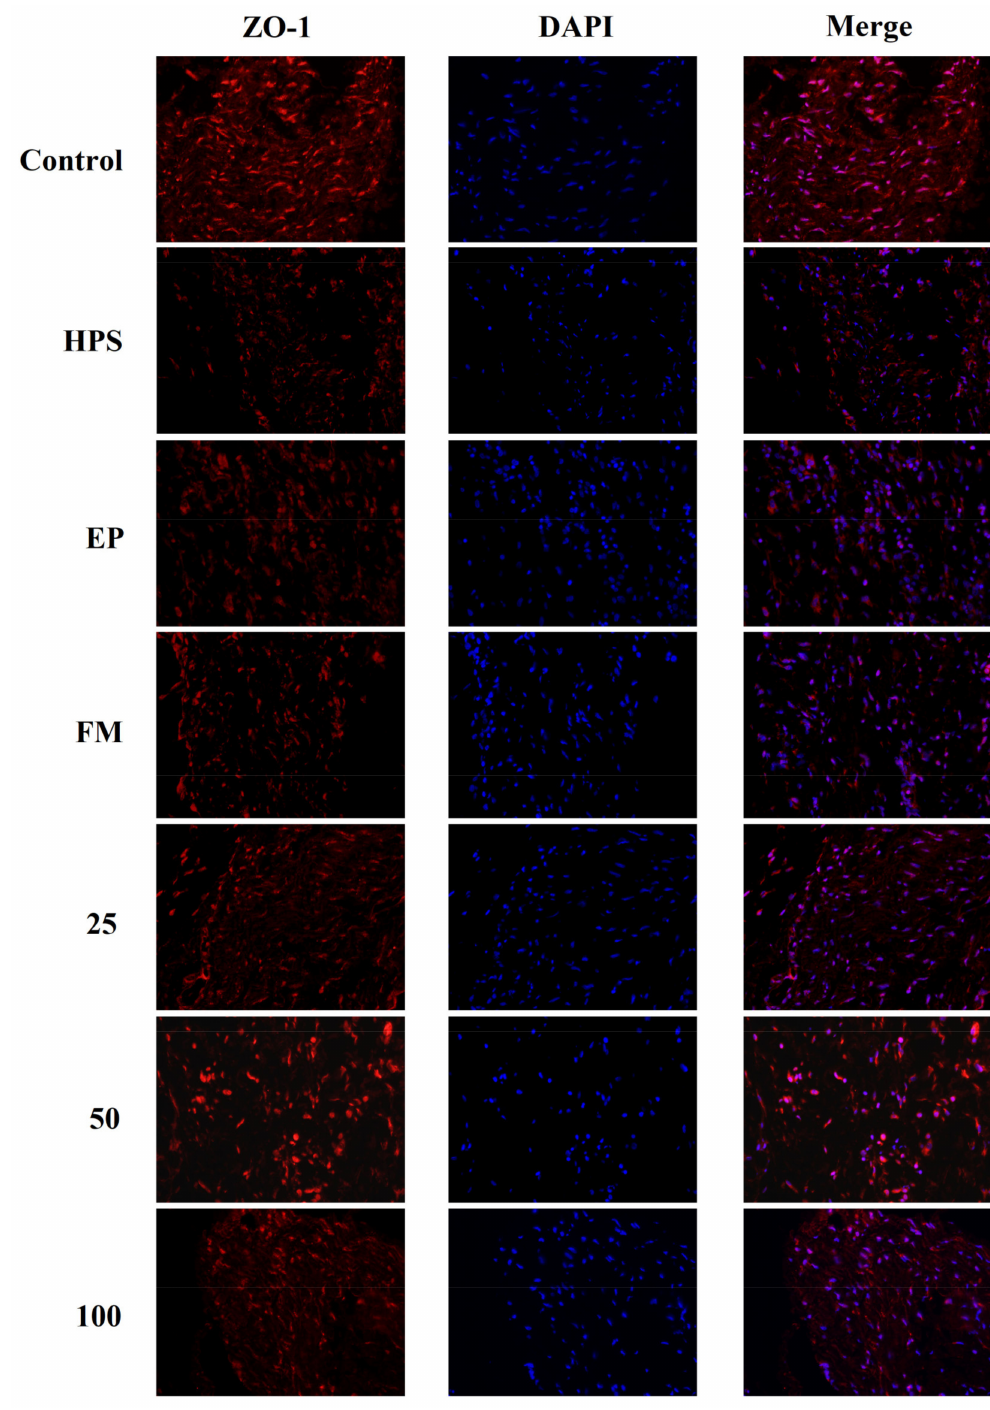
Figure 4. Effect of baicalin on the distribution patterns of ZO-1 in the peritoneum of piglets challenged with G. parasuis (magnification 10 × 40). HPS: G. parasuis group, EP:EP + G. parasuis group, FM:FM + G. parasuis group, 25:25 mg/kg baicalin + G. parasuis group, 50:50 mg/kg baicalin + G. parasuis group, 100:100 mg/kg baicalin + G. parasuis